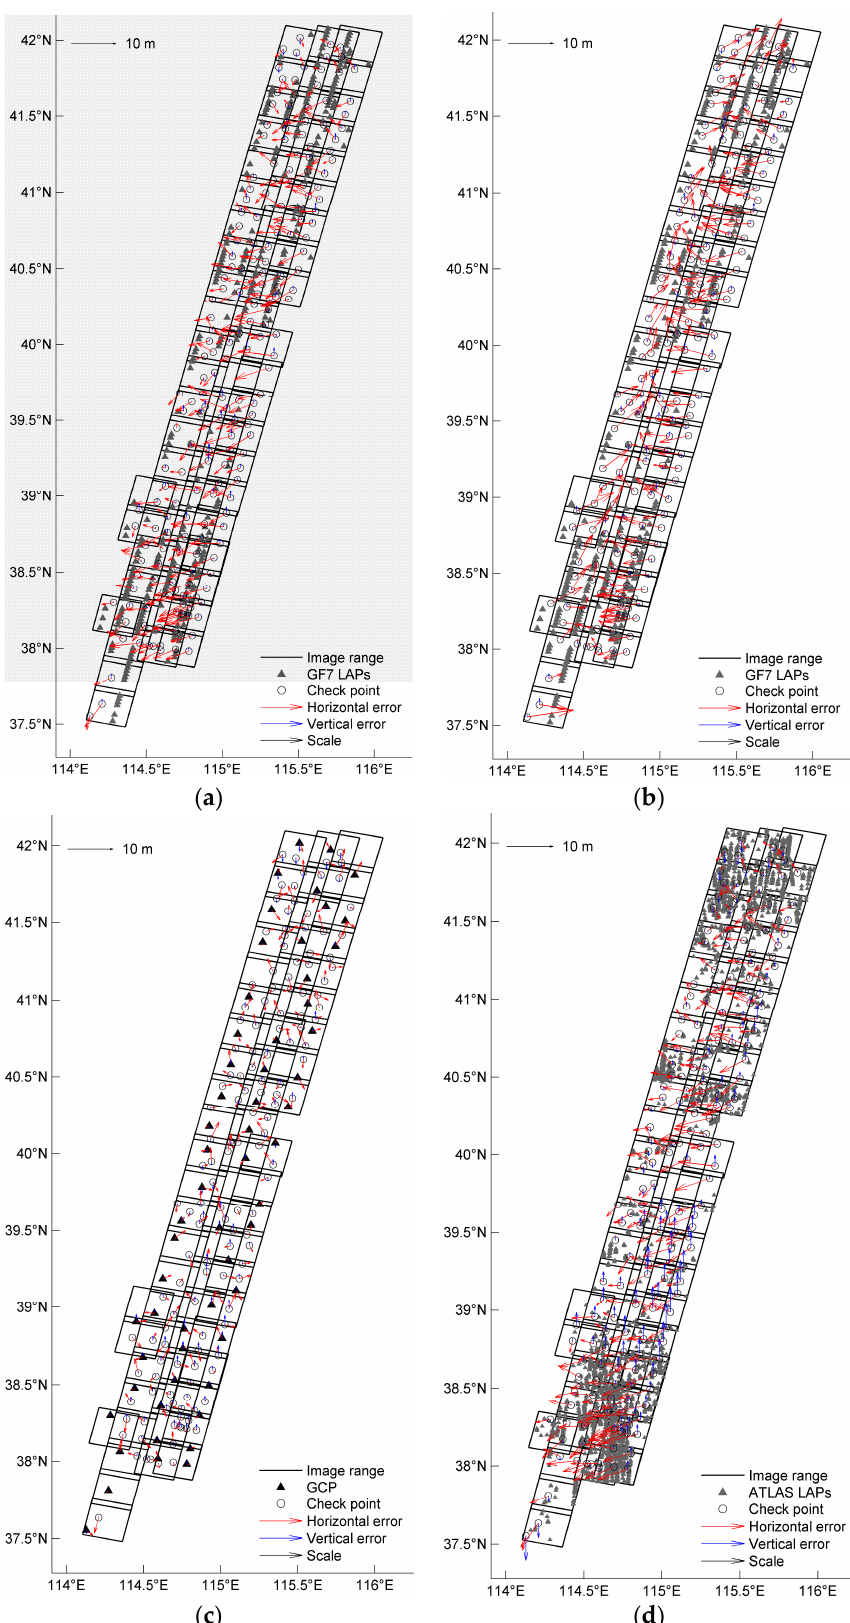
Figure 9. Residuals of integrated processing of GF7 experimental data. ( a ) First group; ( b ) second group; ( c ) third group; and ( d ) fourth group experiments.